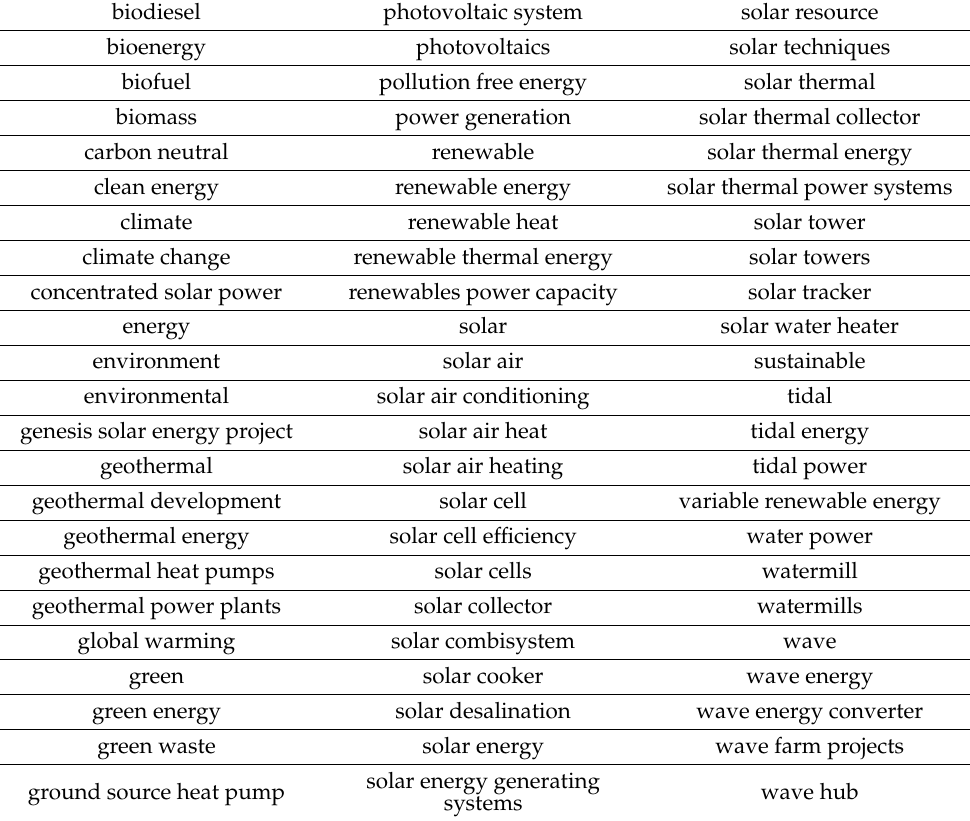
Table A1. Keywords used to collect news headlines related to clean